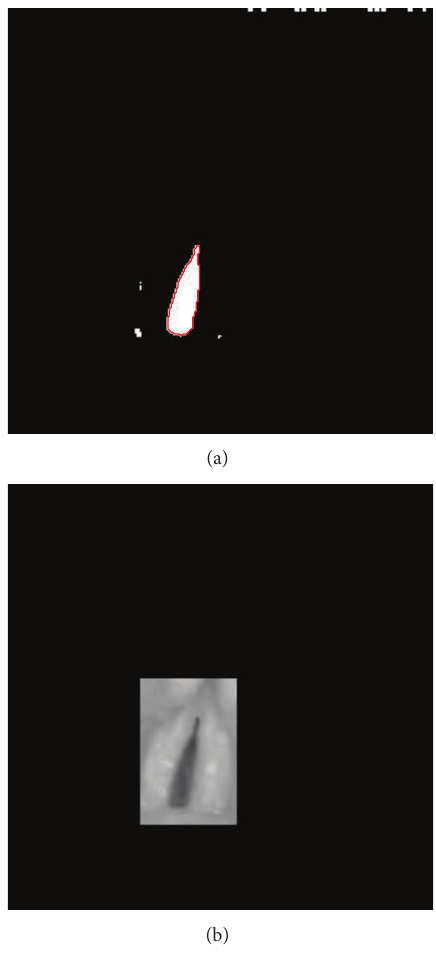
Figure 6: (a) Boundary of the glottal activity region, (b) a masked HSV